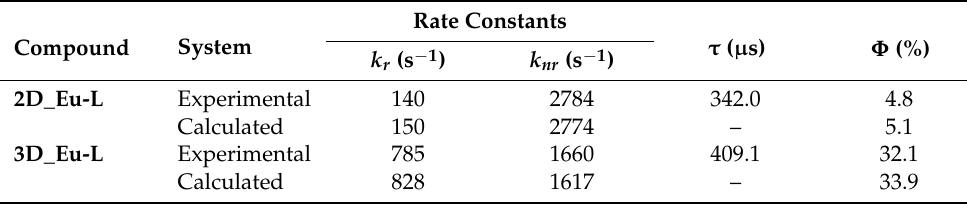
Table 4. Summary of experimental and calculated emission parameters for compounds 2D_Eu-L and 3D_Eu-L